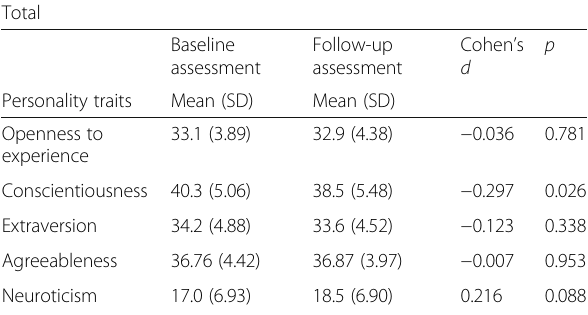
Table 2 Differences between times of assessment on personality traits.